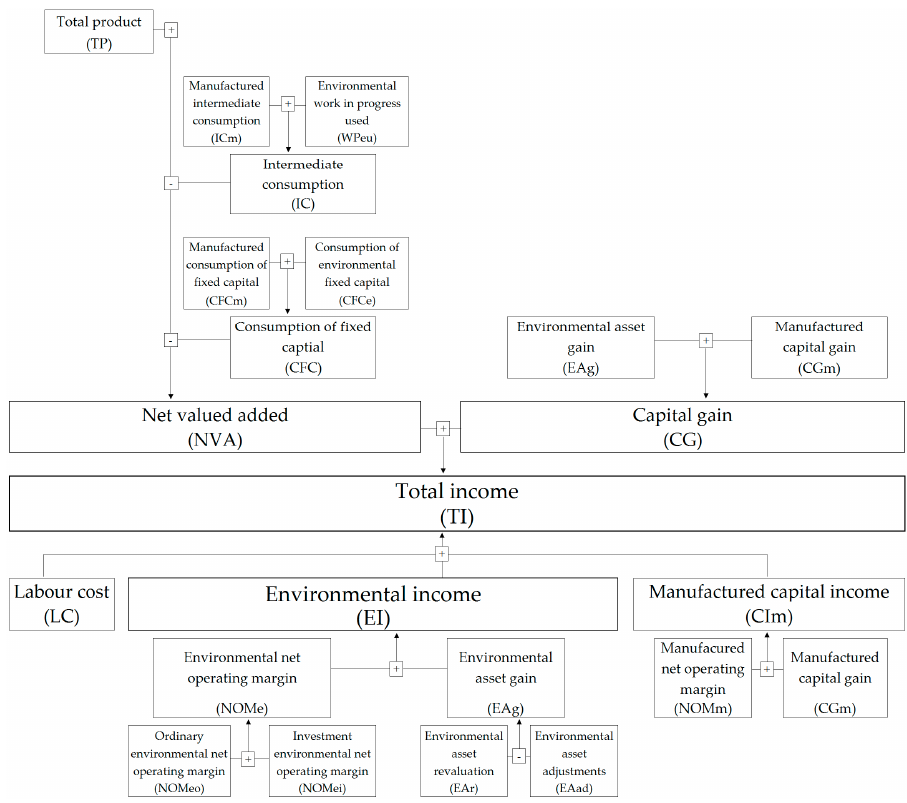
Figure 1. Total income accounting identities applied in holm oak open woodlands in Andalusia, Spain.